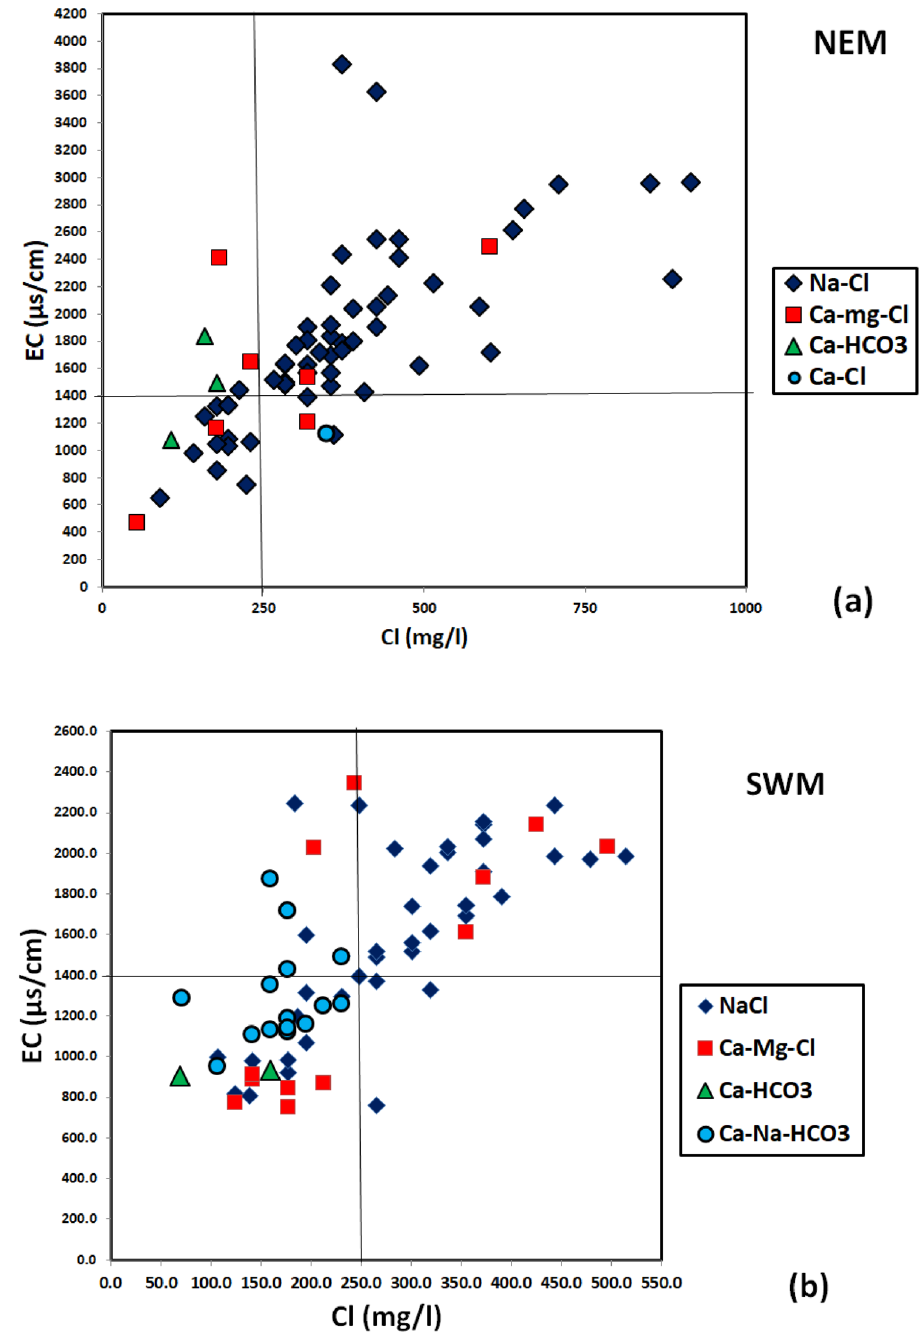
Fig. 5 a Relationship of chloride with EC in catego- rizing the fresh water (FW), sea water intrusion (SW) and mixing (FW + SW) during NEM. b Relationship of chloride with EC in categorizing the fresh water (FW), sea water intrusion (SW) and mixing (FW + SW) during